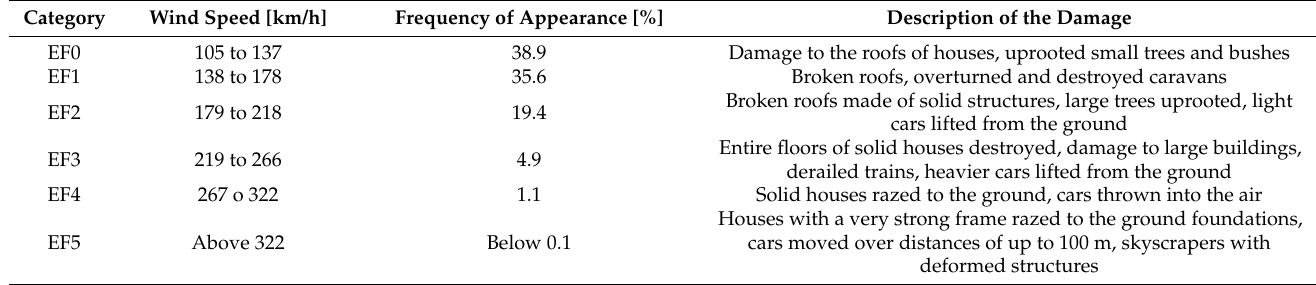
Table 1. Enhanced Fujita Scale